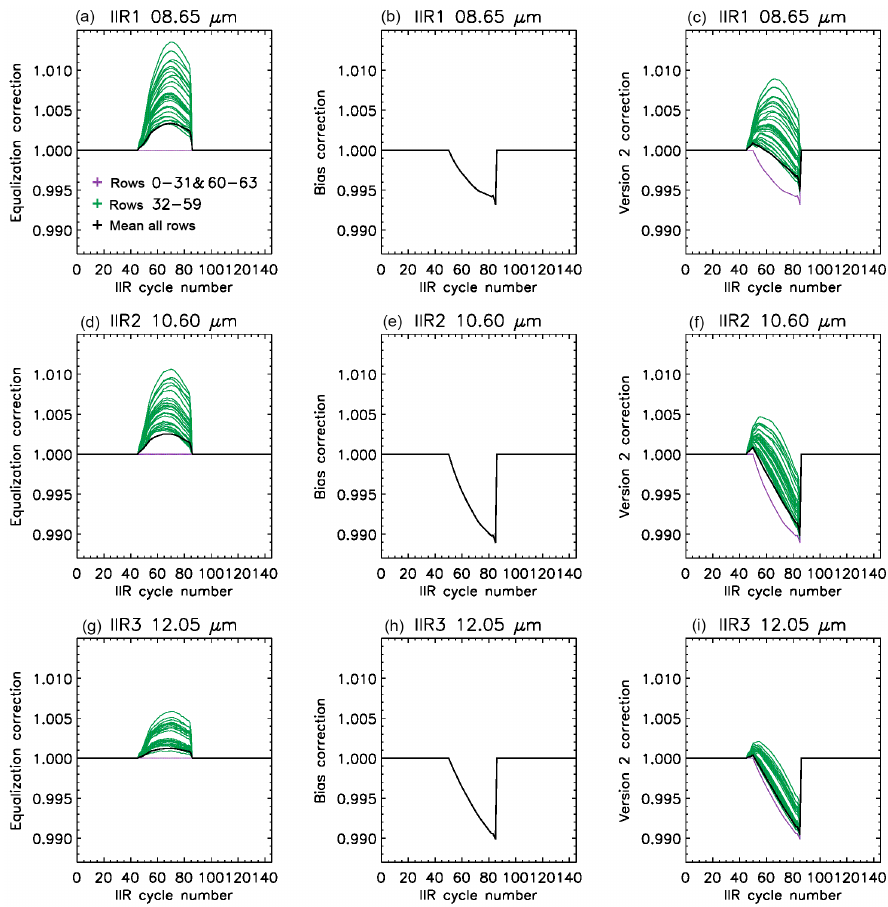
Figure 10. Version 2 correction coefficients applied to Version 1 calibrated radiances ( a–c : IIR1; d–f : IIR2; g–i : IIR3) vs. IIR cycle number for each of the 64 rows. (a, d, g) Equalization correction C eq (i,c,k) ; (b, e, h) bias correction C bias (i,c,k) ; (c, f, i) Version 2 correction, i.e., the product of the equalization and bias corrections. Purple: sound rows; green: flawed rows. The black curve represents the mean correction in an